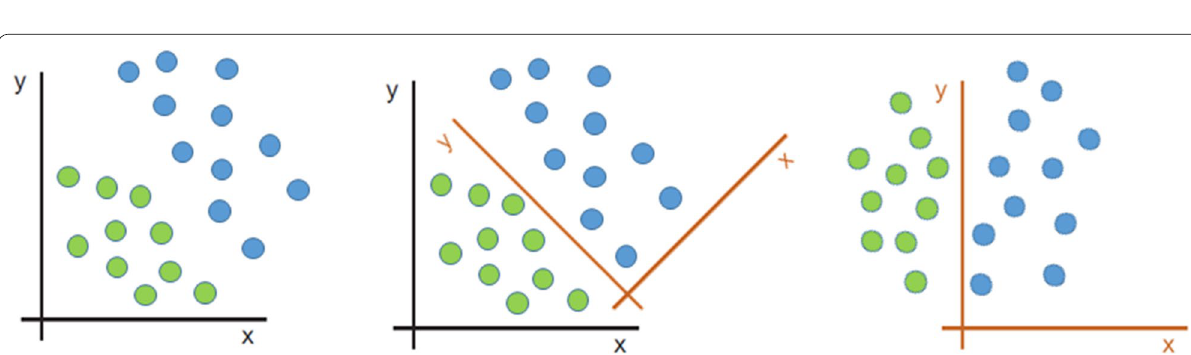
Fig. 4 Solving a two‑dimensional classification problem by eye by changing the data